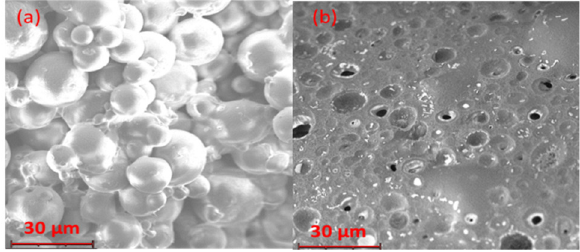
Figure 10. SEM micrographs of sintered disks analyzed after the in vitro drug release studies, ob- tained at 2350× magnification: ( a ) aRB-PCL sintered disk; ( b ) bRB-PCL sintered disk. obtained at 2350 × magnification: ( a ) aRB-PCL sintered disk; ( b ) bRB-PCL sintered